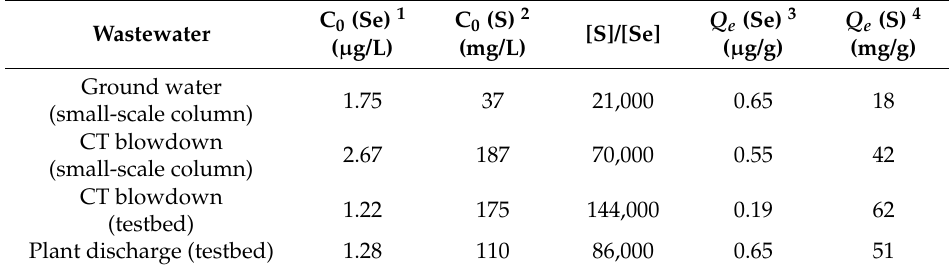
Table 5. Test results for LDH removal of Se from column tests. The ground water results are from reference